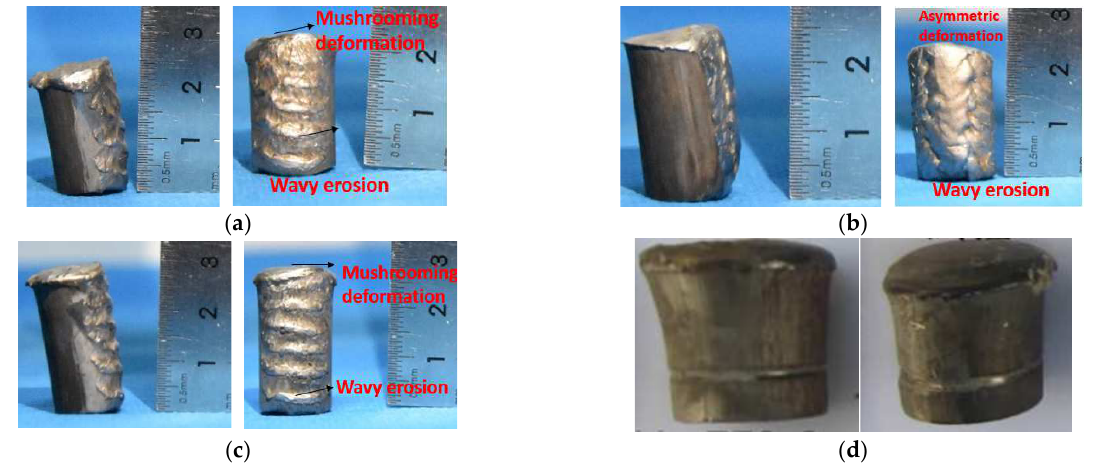
Figure 12. The remaining projectile after the tests. ( a ) Remaining projectile in Test 1; ( b ) remaining projectile in Test 2; ( c ) remaining projectile in Test 3; ( d ) remaining projectile under normal pene- tration [24].